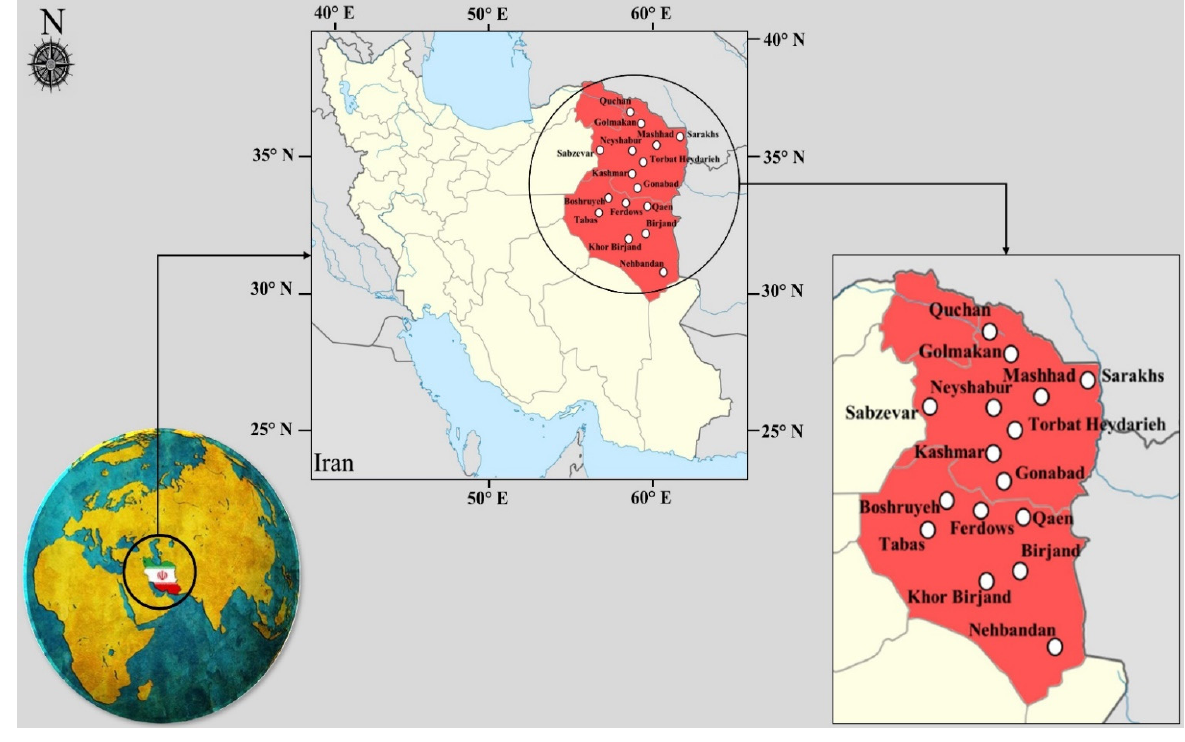
Figure 5. Case study locations. Atmosphere 2022 , 13 , 758